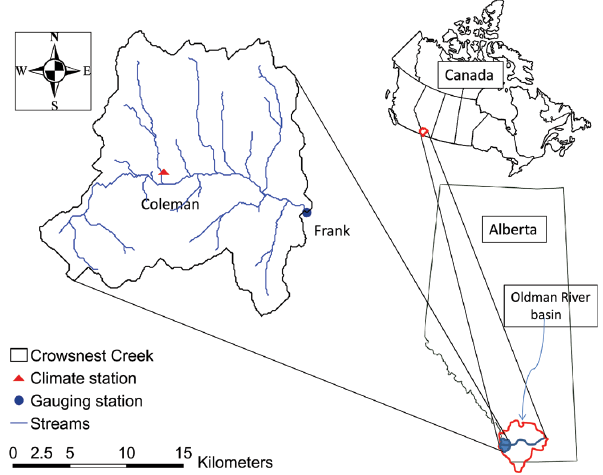
Fig. 1. Crowsnest Creek watershed with climate station, Coleman, and gauging station, Crowsnest at